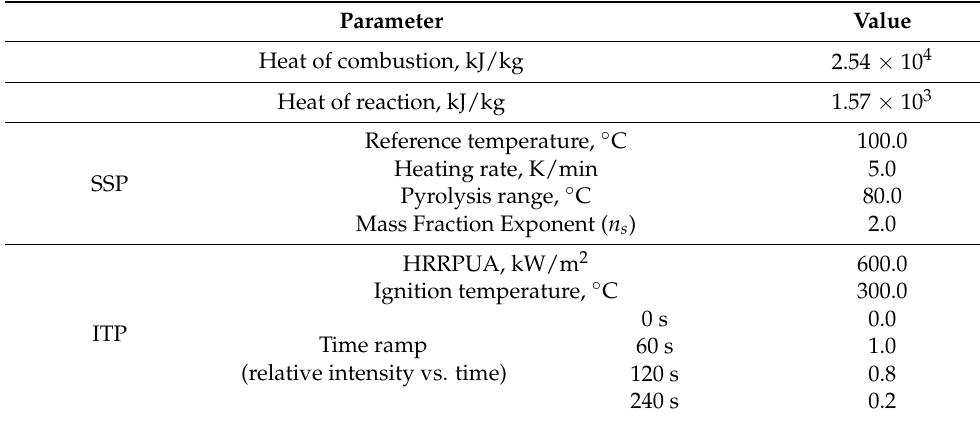
Table 4. Parameters of material burnout.